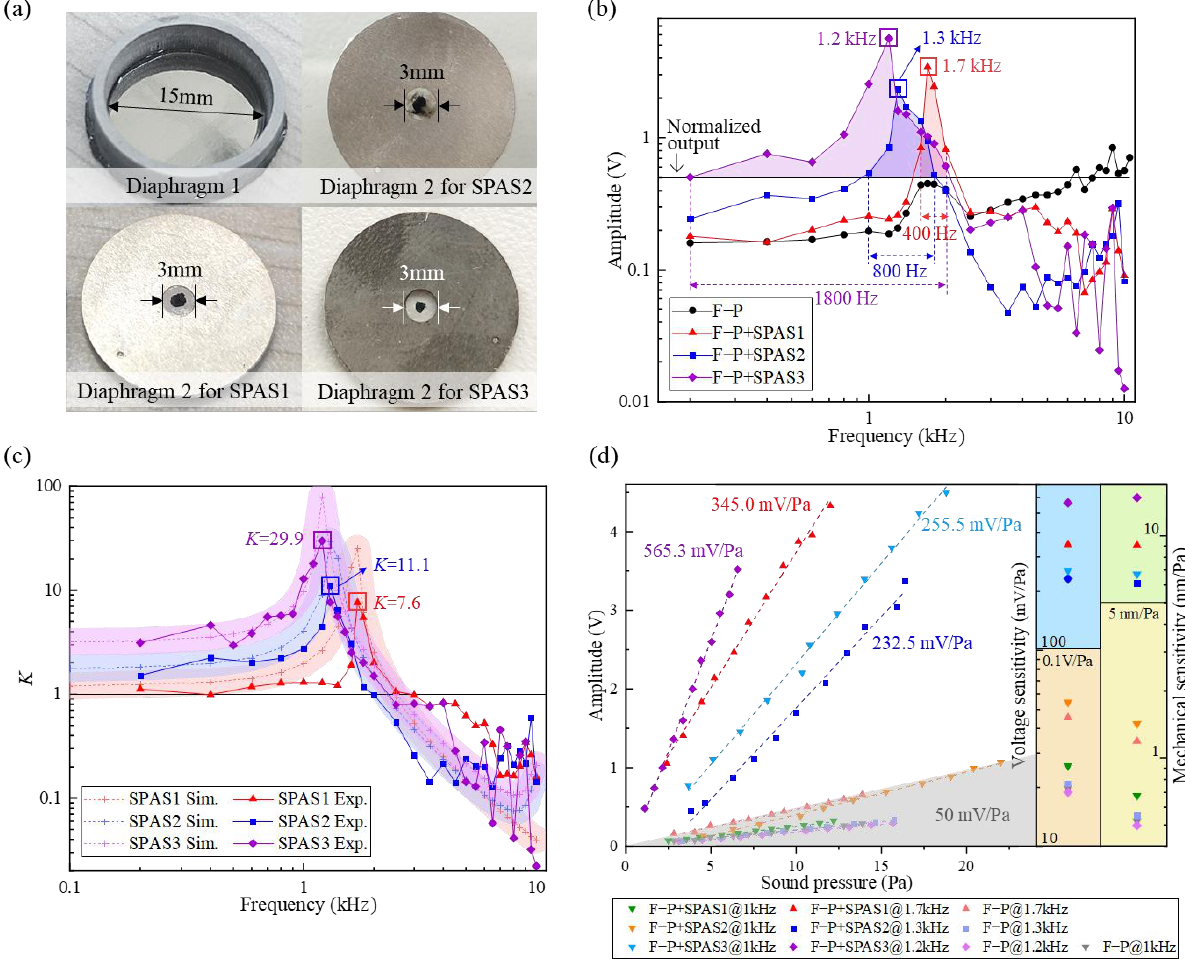
Figure 7. ( a ) Diaphragms 1 and 2 for the acoustic test. ( b ) Measured frequency response with or without SPAS, ( c ) K value and ( d ) acoustic sensitivity for the F-P sensors with SPAS1, SPAS2, and SPAS3. Note that the black horizontal line in ( b ) represents the normalized output from the reference microphone.